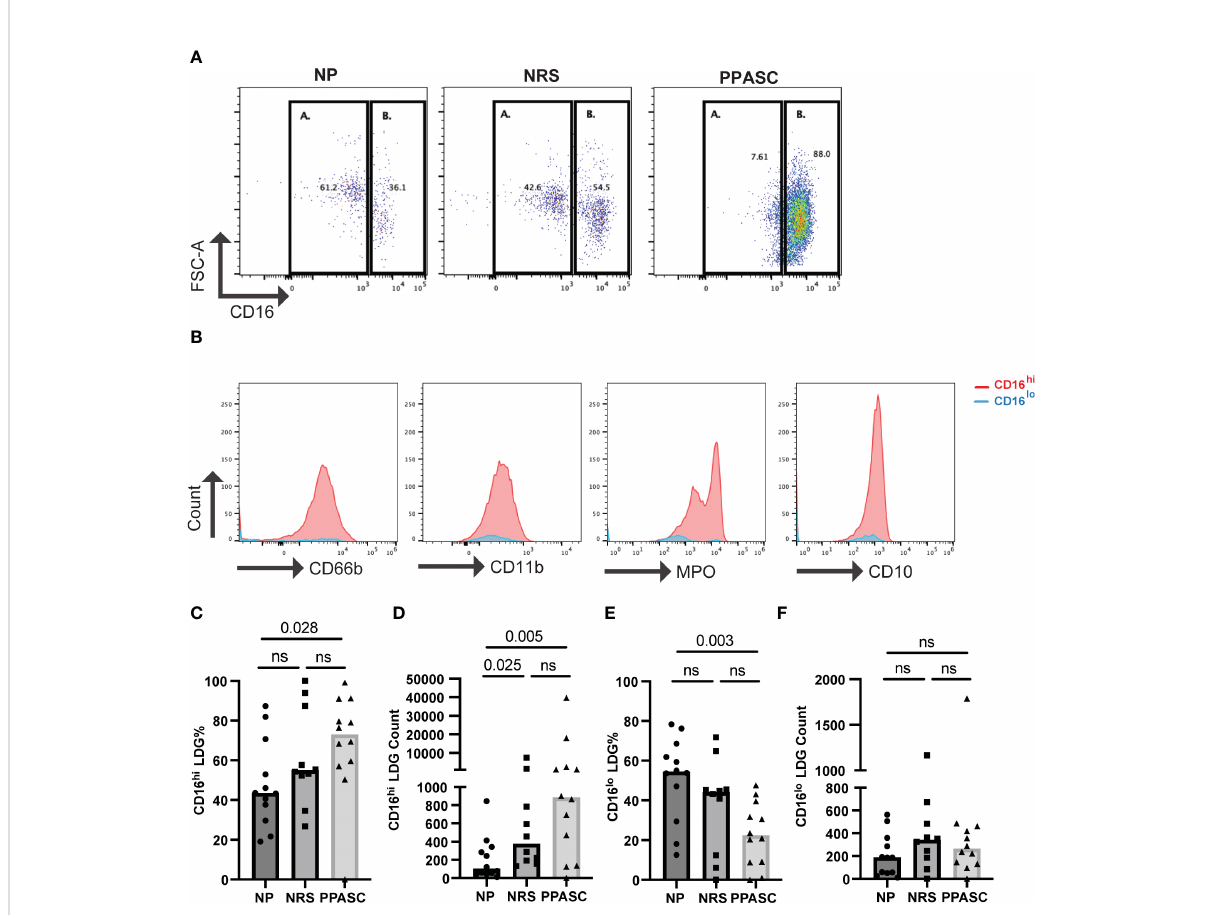
FIGURE 4 Representative dot plot showing LDG populations in NP, NRS, and PPASC separated into CD16 lo (A) and CD16 hi (B) populations (A) Representative histograms showing expression of CD66b, CD11b, MPO, and CD10 in LDG populations from PPASC participants according to CD16 lo (blue) and CD16 hi (red) delineation (B) CD16 hi LDG % in NP, NRS, and PPASC groups (C) CD16 hi LDG counts in NP, NRS, and PPASC groups (D) CD16 lo LDG % in NP, NRS, and PPASC groups (E) CD16 lo LDG count in NP, NRS, and PPASC groups (F) Mann-Whitney U Test, ns, non-signi fi cant, p >